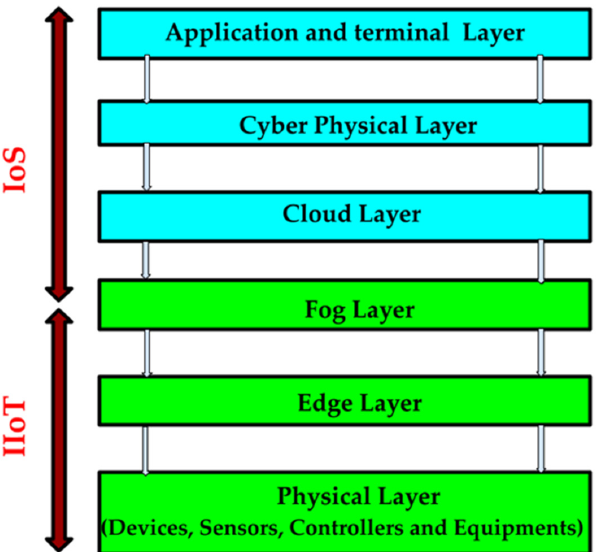
Figure 2. Interface between Internet of Services (IoS) and Industrial IoT (IIoT), and its interface with network architecture for the smart factory.